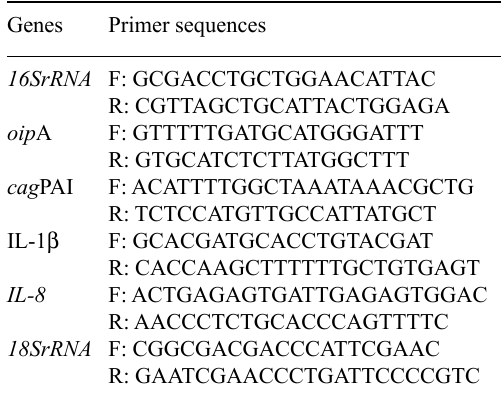
Table 1. Primers used in the study